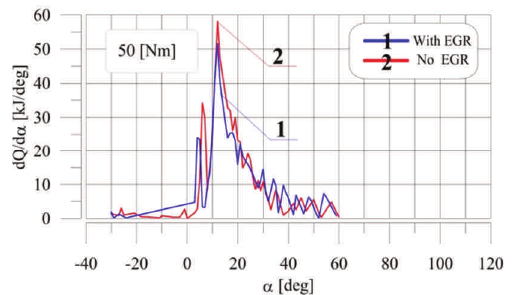
Fig. 14. Influence of the engine crank angle on the rate of heat release inside cylinder for engine operating with/without EGR at torque 50 Nm